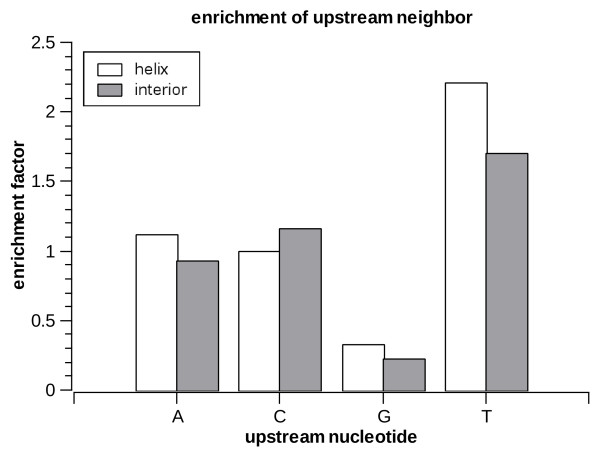
Enrichment factors for upstream nucleotide in helices and interior loops.